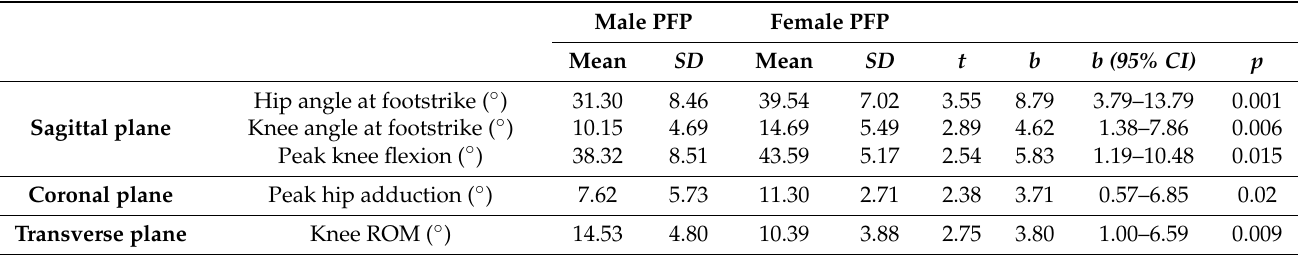
Table 10. Three-dimensional kinematics in male and female PFP participants.